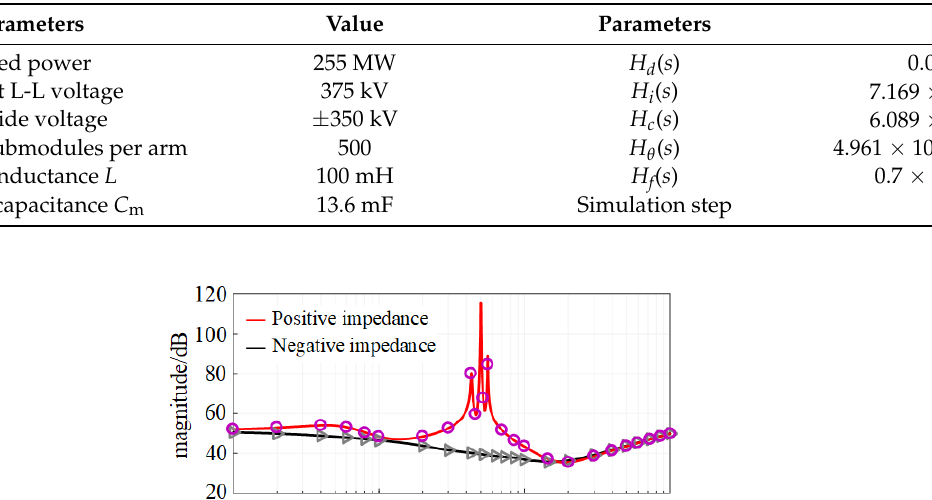
Table 1. Parameters of MMC-HVDC in simulation.